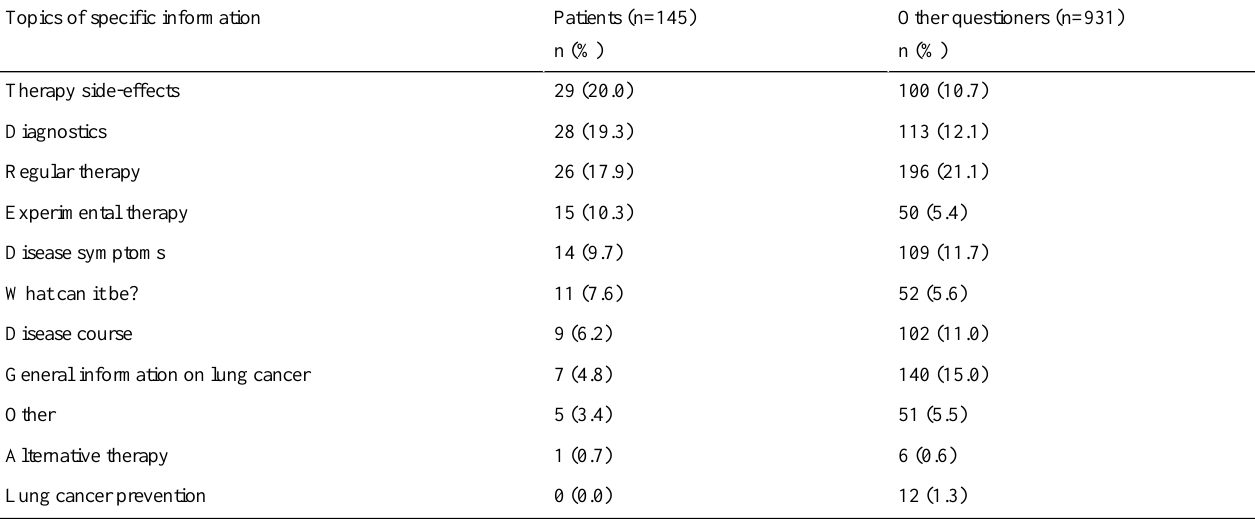
Table 5. Topics of required specific information on lung cancer and lung cancer therapy, patients, and other